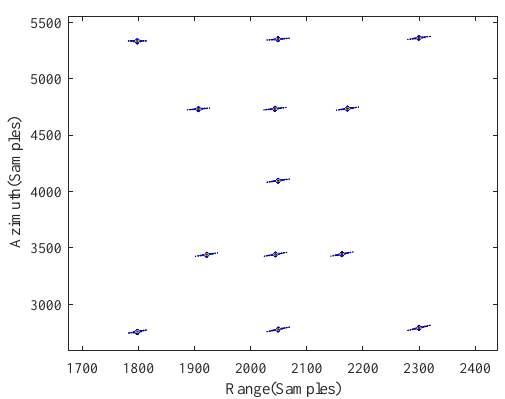
Figure 11. Imaging results of the seven simulated targets.